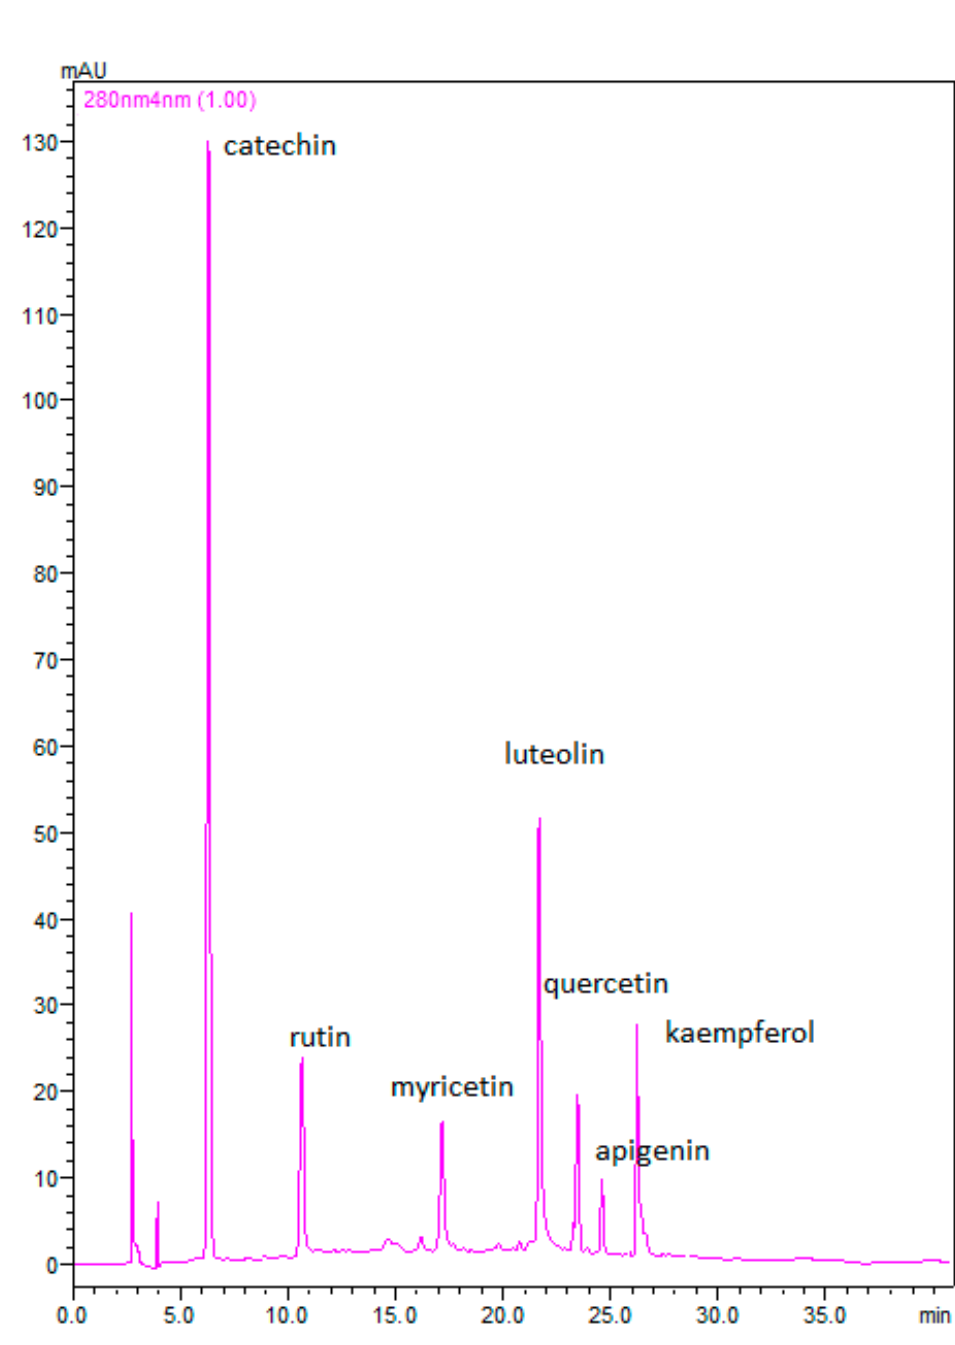
Figure 1. Characteristic chromatogram of a walnut septum extract; monitored at 280 nm.